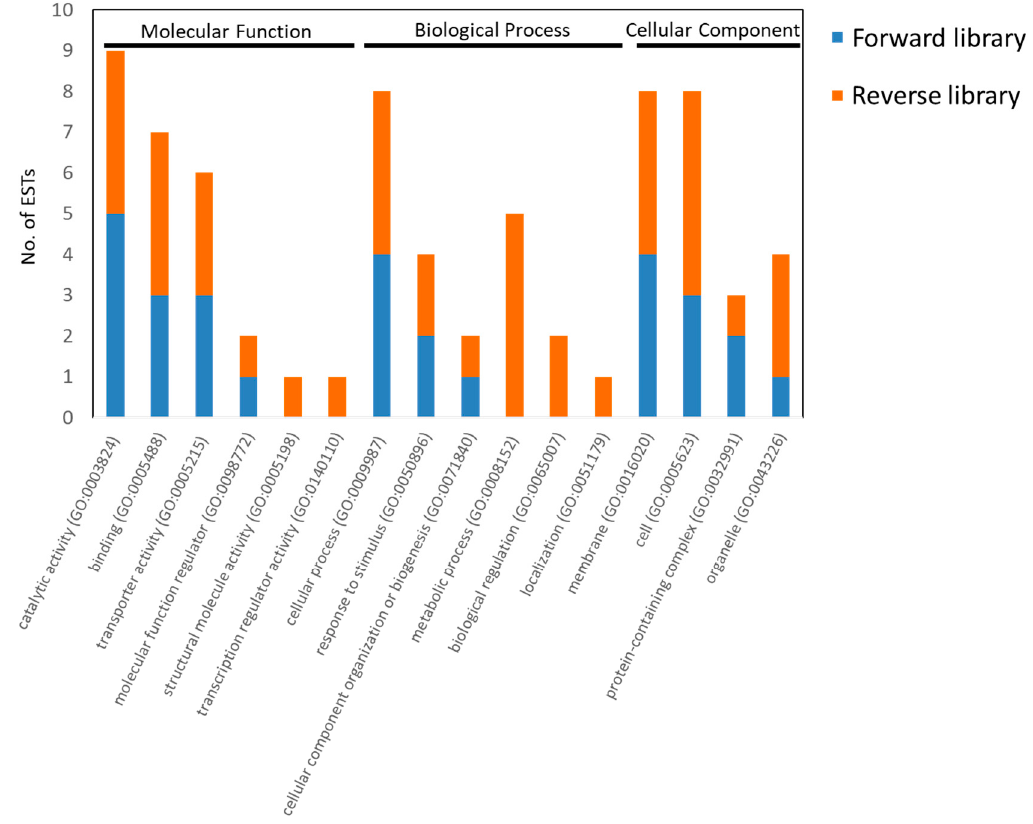
Figure 3. Gene Ontology (GO) analysis of 47 host insect ESTs from forward library (13 ESTs) and reverse library (34 ESTs).